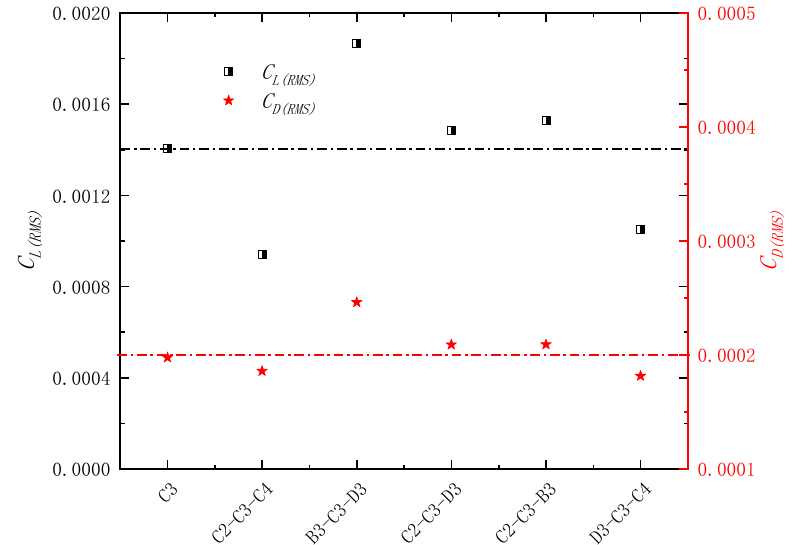
Figure 14. Comparison of the lift and drag coefficient of C3 in the time domain.